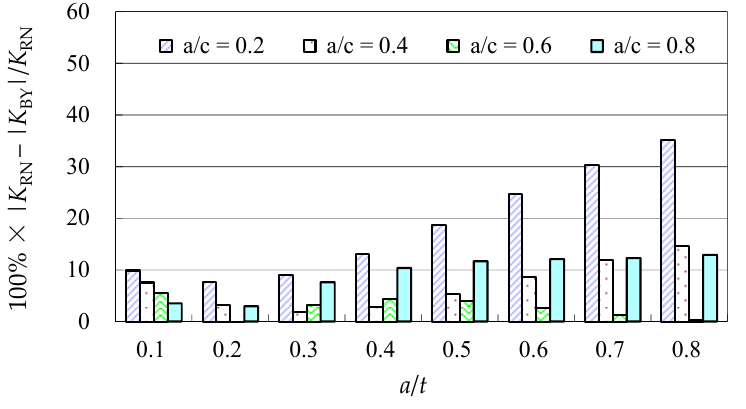
Figure 3. The Baik-Yamada formula vs. the Raju-Newman solution at point A ( c / W = 0.1).